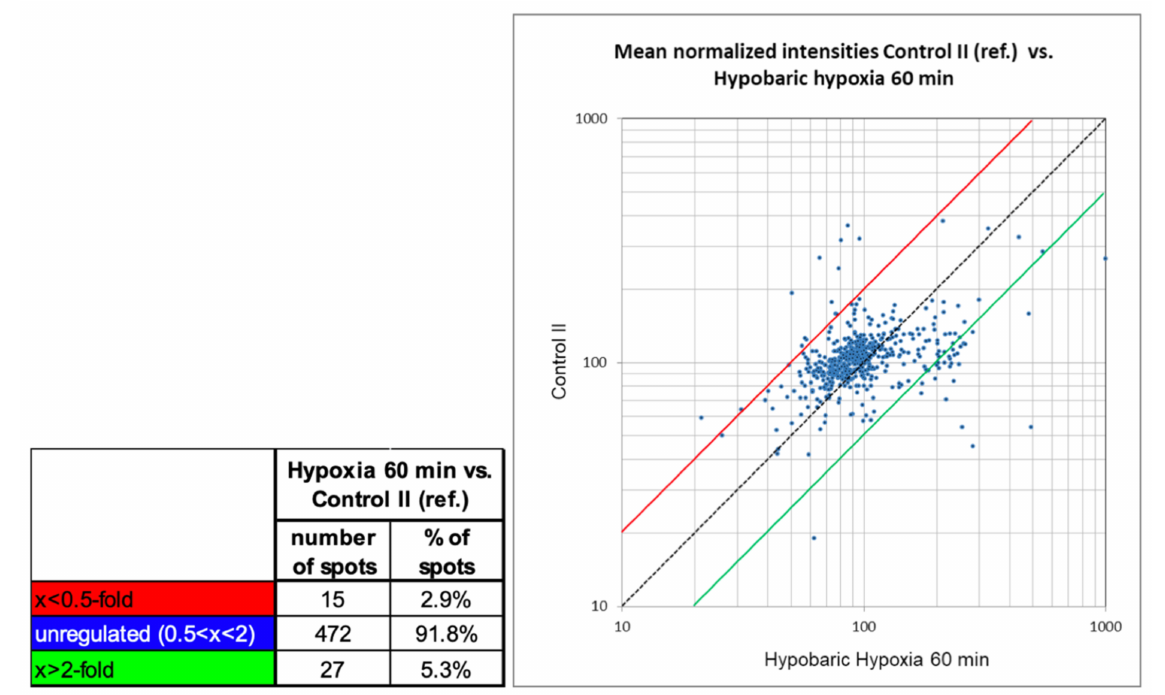
Figure 5. Summary of quantitative changes of comparison 2: HH60 versus GC60.